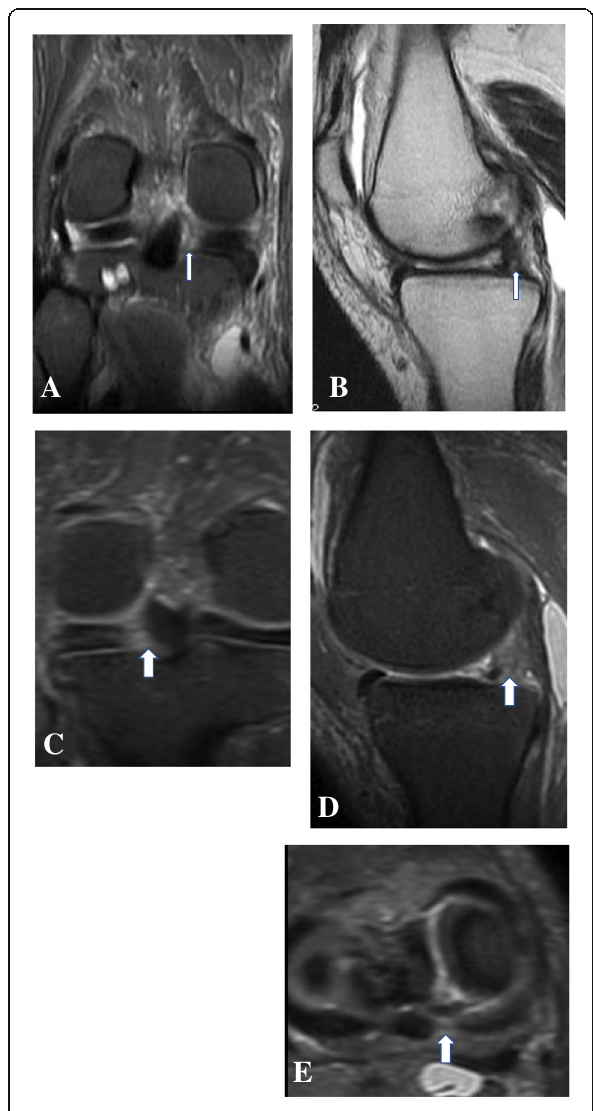
Fig. 5 A 30-year-old female patient presented by right knee pain with history of trauma. a , b Coronal standard 2D PD WI and sagittal T2 standard 2D images, showing medial meniscus posterior root full thickness radial tear, white straight arrows. c – e 3D MPR VISTA images (coronal, sagittal, and axial), clearly outlining the posterior root full thickness radial tear, white straight arrows